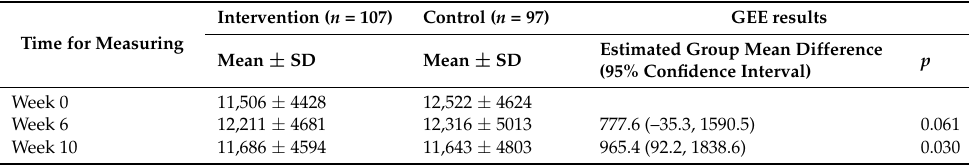
Table 2. Generalised estimating equations (GEE) results on the average number of steps taken daily over time between the intervention group (IG) and control group (CG).